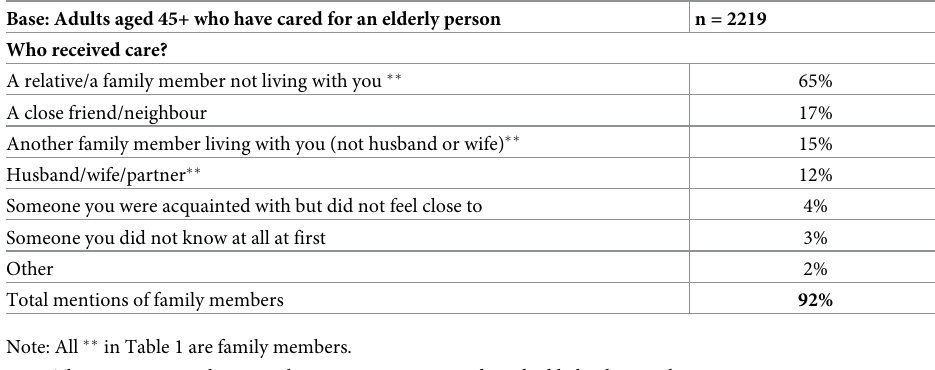
Table 1. Recipients of